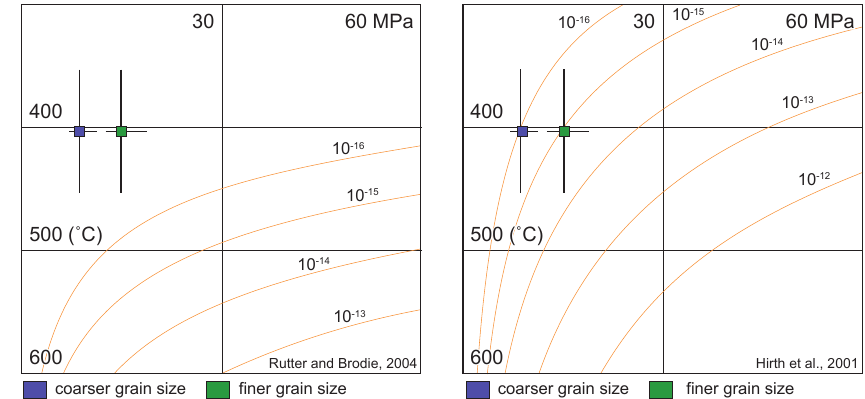
Figure 6. Strain rate estimates for the two size-populations within the quartz-rich lenses using the flow laws of Hirth et al. (2001) and Rutter and Brodie (2004). Differential stress estimates are from recrystallized grain-size piezometry while temperature estimates are from quartz crystallographic fabric opening angles. See text for